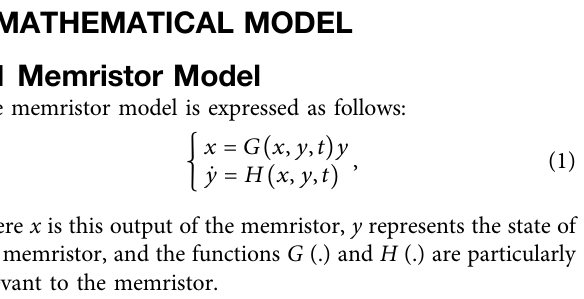
Frontiers in Physics |